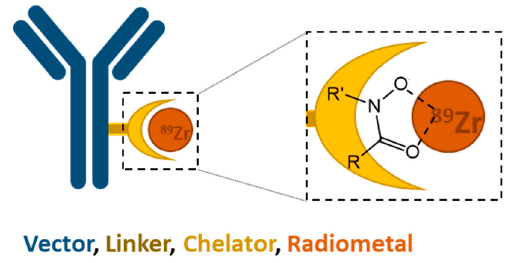
Figure 1. Schematic representation of a biological vector (antibody) conjugated via a linker to a hydroxamate chelator and radiolabeled with 89 Zr. The enlargement shows the O,O-coordination between the electron rich oxygen atoms and the radiometal cation 89 Zr forming a stable five-